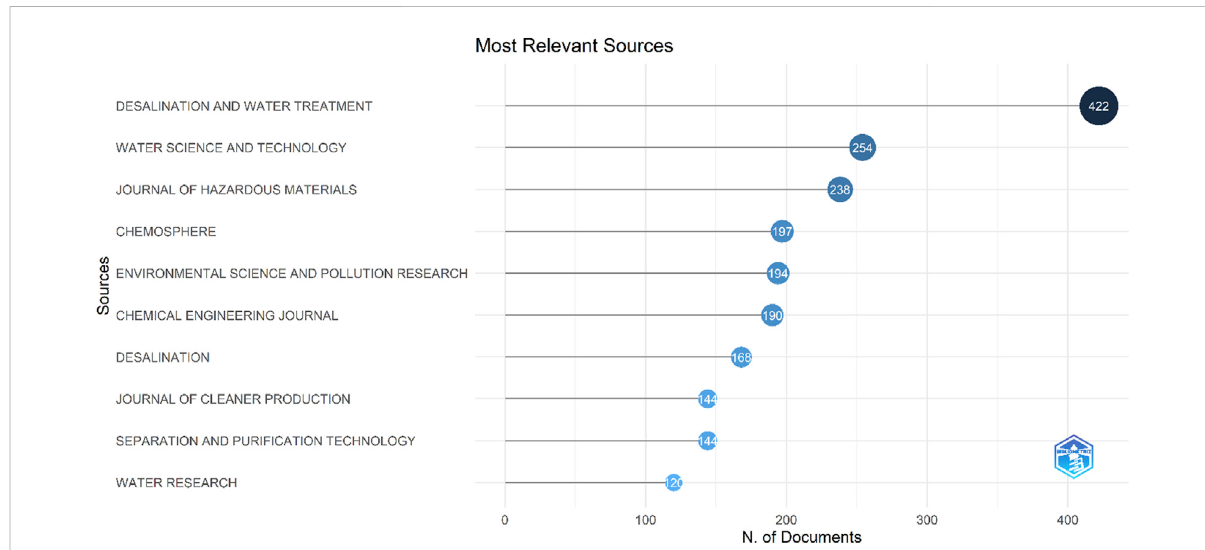
FIGURE 3 Most relevant sources. The x-axis indicates the number of documents; the y-axis shows the sources. The top 10 most relevant sources have been identi fi ed based on the number of